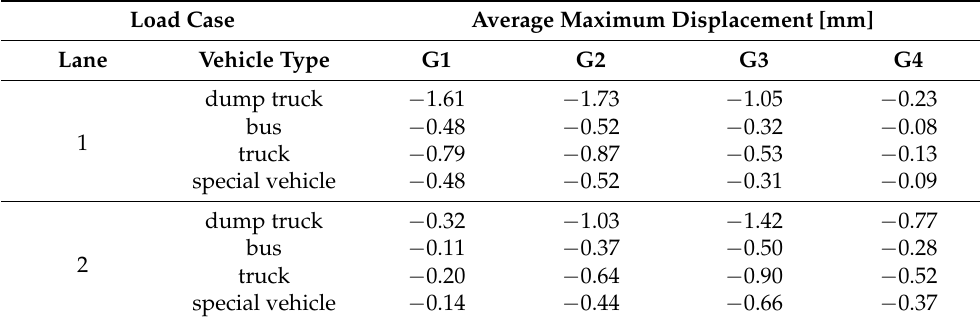
Table 6. Average maximum displacement of the static component extracted for each vehicle type and lane.